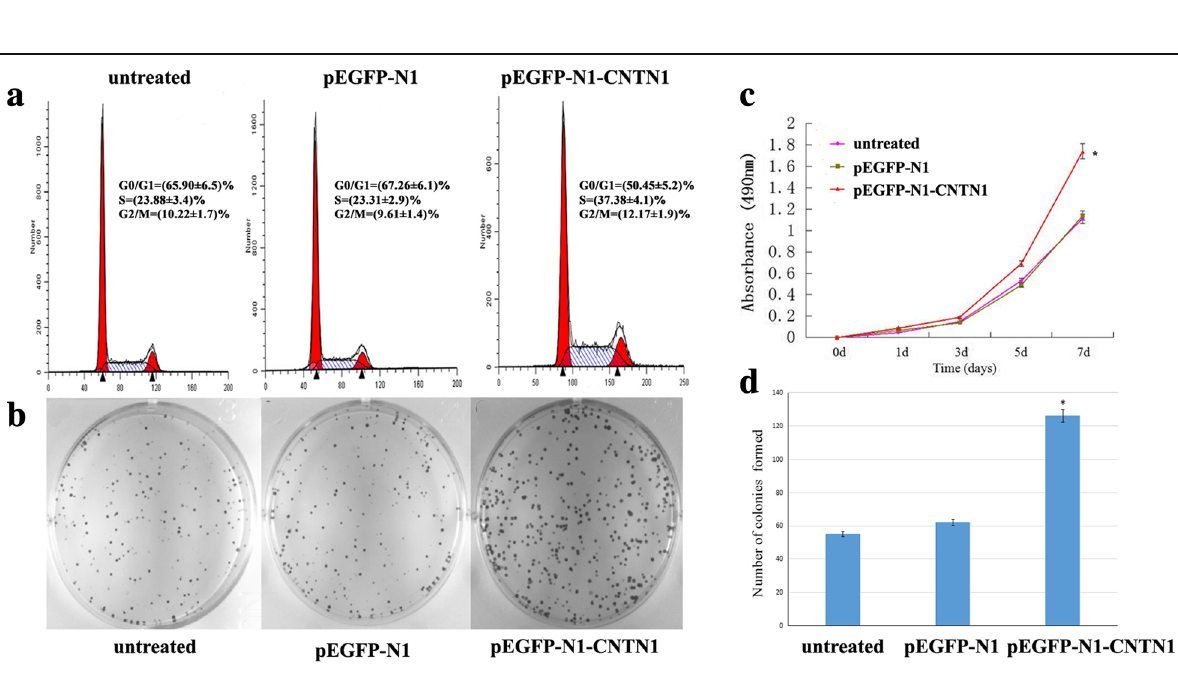
Fig. 3 Exogenous CNTN1 induces cell proliferation and growth of Hs578T cells. a Cell cycle analysis of CNTN1 transfected cells and untransfected cells; percentage of cells in each phase of the cell cycle are indicated. The experiments were performed in triplicate and results are represented as mean ± standard error. b Colony formation assay indicates that CNTN1 overexpression led to an increase in colony number; c MTT assay of CNTN1 overexpressing cells: compared to controls, OD was significantly higher in CNTN1-transfected group (* P <0.05); d Representative bar